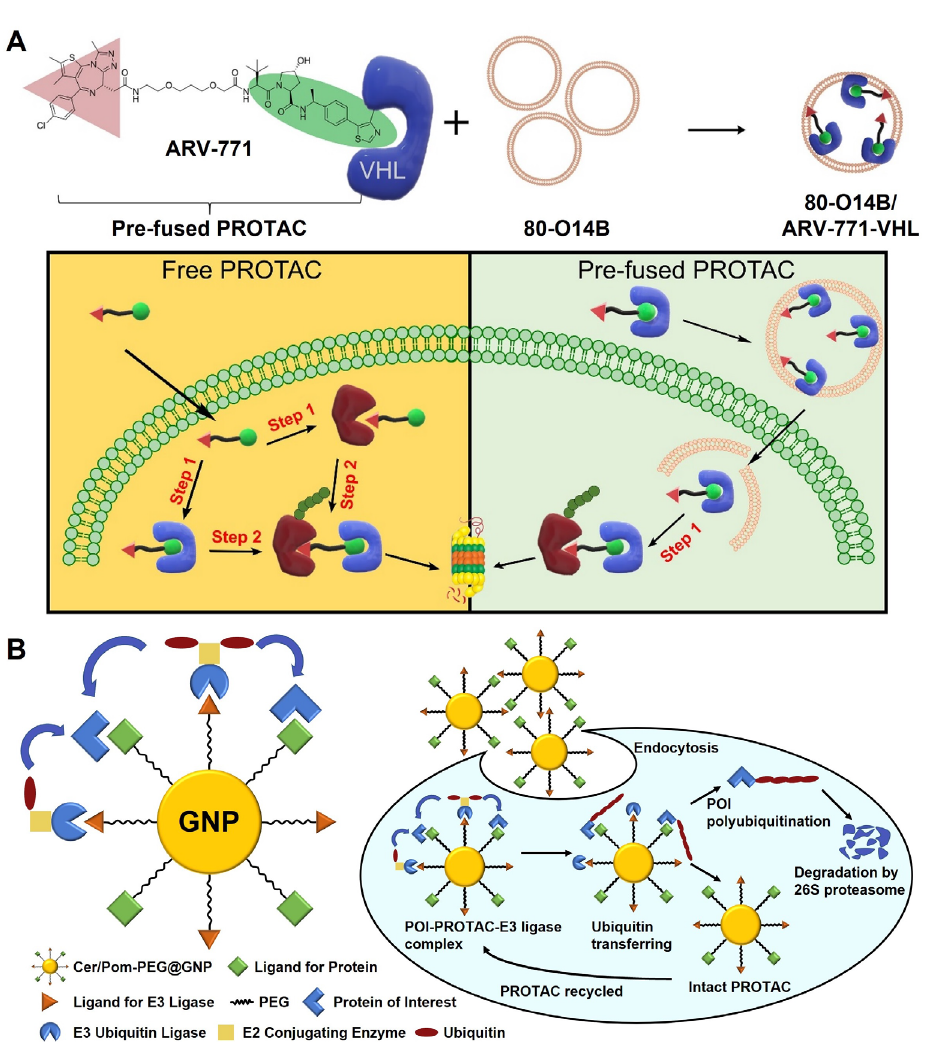
Figure 3. Nanoparticle-based PROTAC delivery. ( A ) Lipid nanoparticle-based PROTAC delivery. BRD4-degrading PROTACs pre-fused with VHL E3 ligases were encapsulated in 80-O14B lipid nanoparticles. The lipid nanoparticle assisted the transfer of pre-fused PROTACs to cytosols,